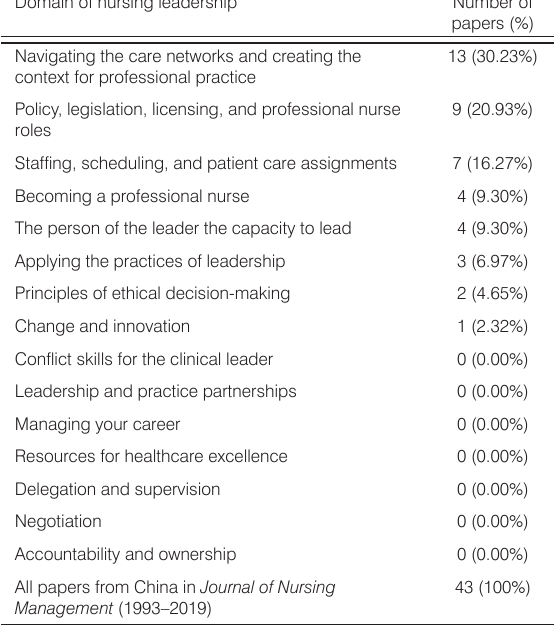
Table 6. An outline of patterns and trends in papers from the People’s Republic of China published in the Journal of Nursing Management according to Weberg et al.’s outline of the leadership role in